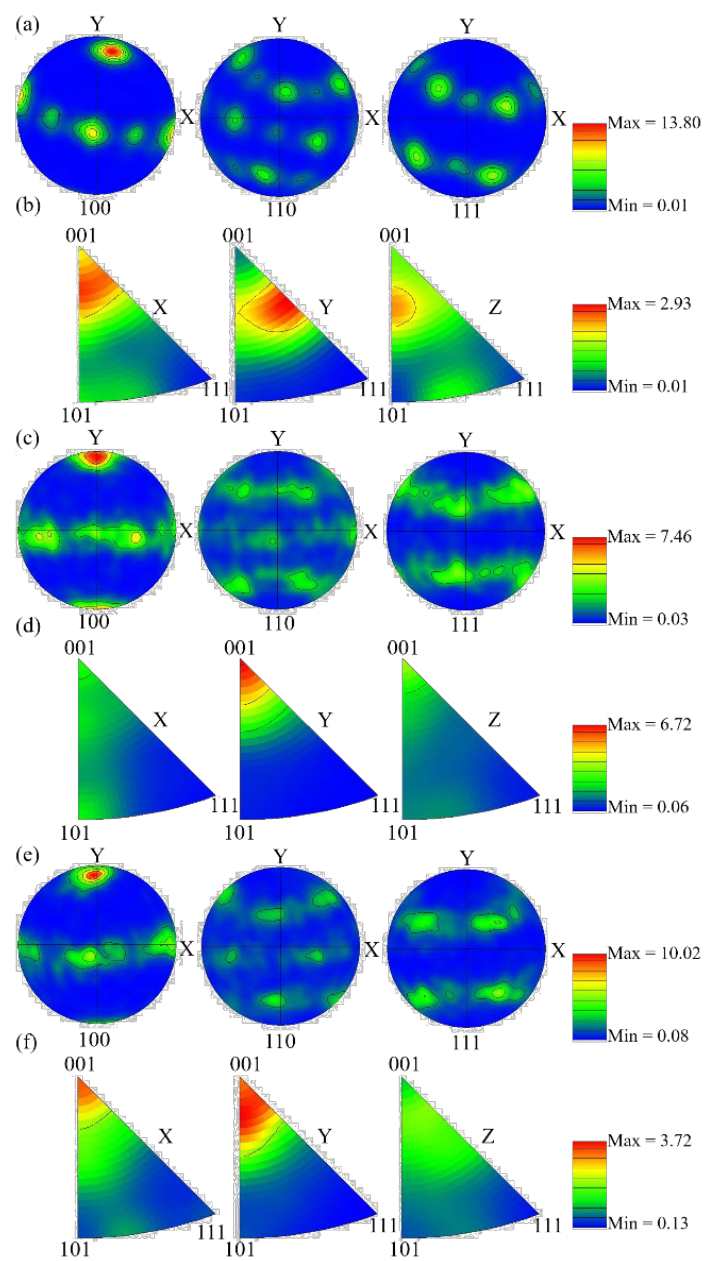
Figure 6. The polar diagrams (( a ) 800 mm/s; ( c ) 1200 mm/s; ( e ) 1600 mm/s) and anti-polar diagrams (( b ) 800 mm/s; ( d ) 1200 mm/s; ( f ) 1600 mm/s) of K418 alloy at different scanning speeds.